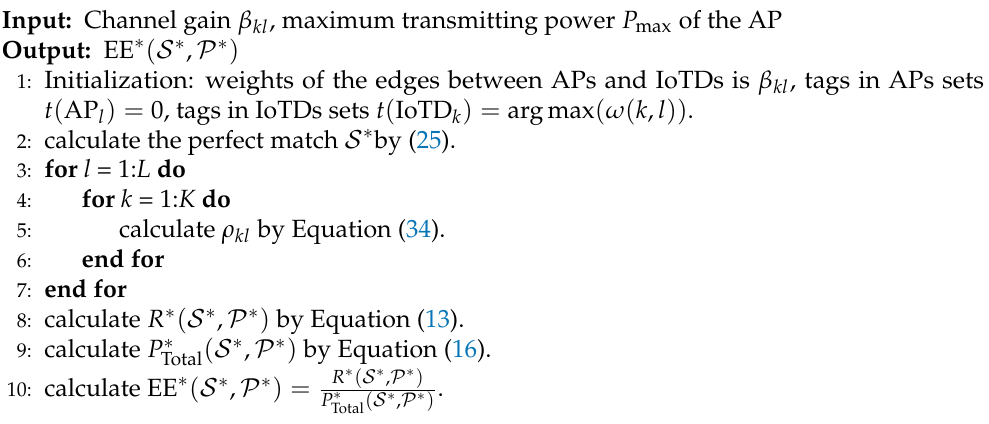
Algorithm 1 KM-based AP selection and Full Power Allocation